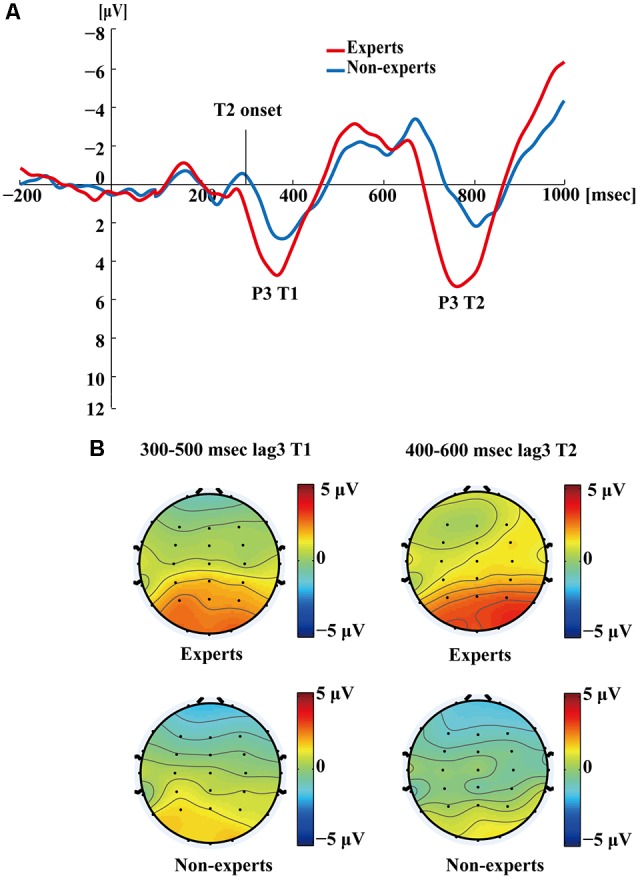
(A) Grand averages of the mean activation at Pz of experts and non-experts as a function of time for lag3 trials during which an attentional blink did not occur (nonblink trials). Owing to the onset proximity of T1 and T2, we drew the waves induced by both targets together. ERPs were time locked to the onset of T1. (B) The scalp distribution of 300–500 ms time windows for dual-target condition at lag3 for T1. The scalp distribution of 400–600 ms time windows for dual-target condition at lag3 for T2.